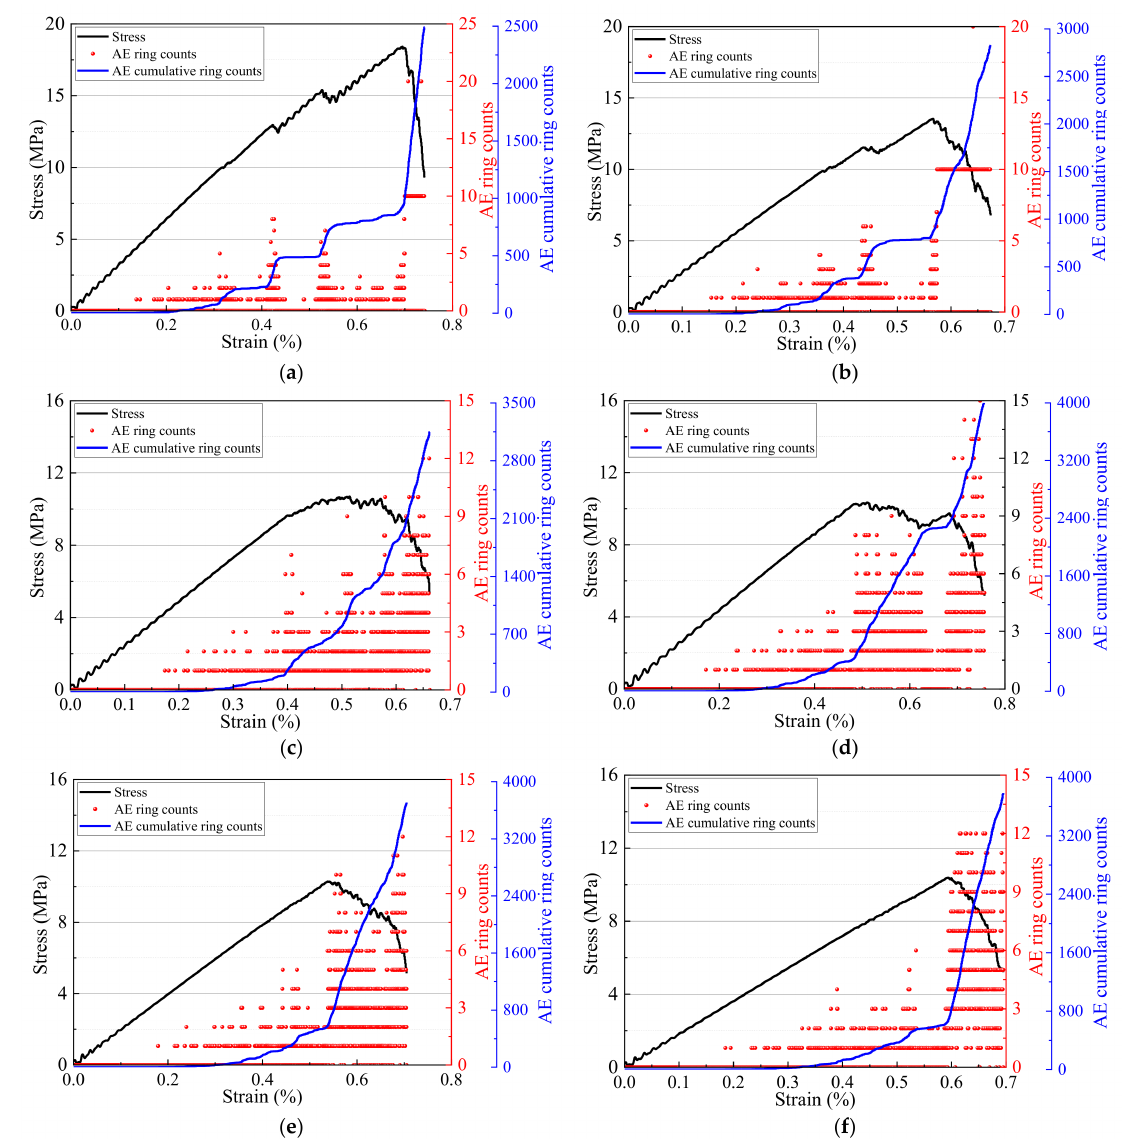
Figure 7. Stress-AE ring count–AE cumulative ring count curves: ( a – f ): RCF2–RCF7.